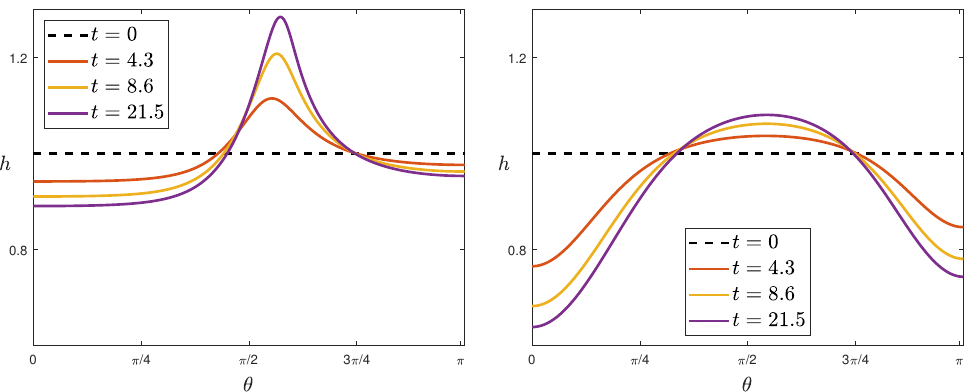
Figure 8. Evolution of the film thickness at t = 4.3, 8.6, 21.52. Dashed line: initial film thick- ness h ( θ , t = 0 ) = 1. ( left ) Oblate spheroid γ = 0.5, dimensionless angular velocity Ω d = 0.08; ( right ) Prolate spheroid γ = 2, dimensionless angular velocity Ω d =